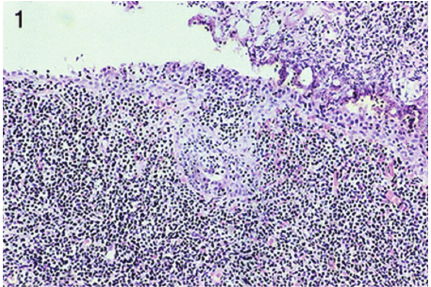
Figure1:Themicroscopicfeatureofthesecondcases(haematoxylin and eosin staining). Case 2: mucosa-associated lymphoid tissue lymphoma involving the lamina propria of the urinary blad- der (hematoxylin-eosin, original magnification × 100). Reproduced from [4] with permission of the Editor-in-Chief of Archives of Pathology and Laboratory Medicine on behalf of the editorial team of the journal and the American Association of Pathology.